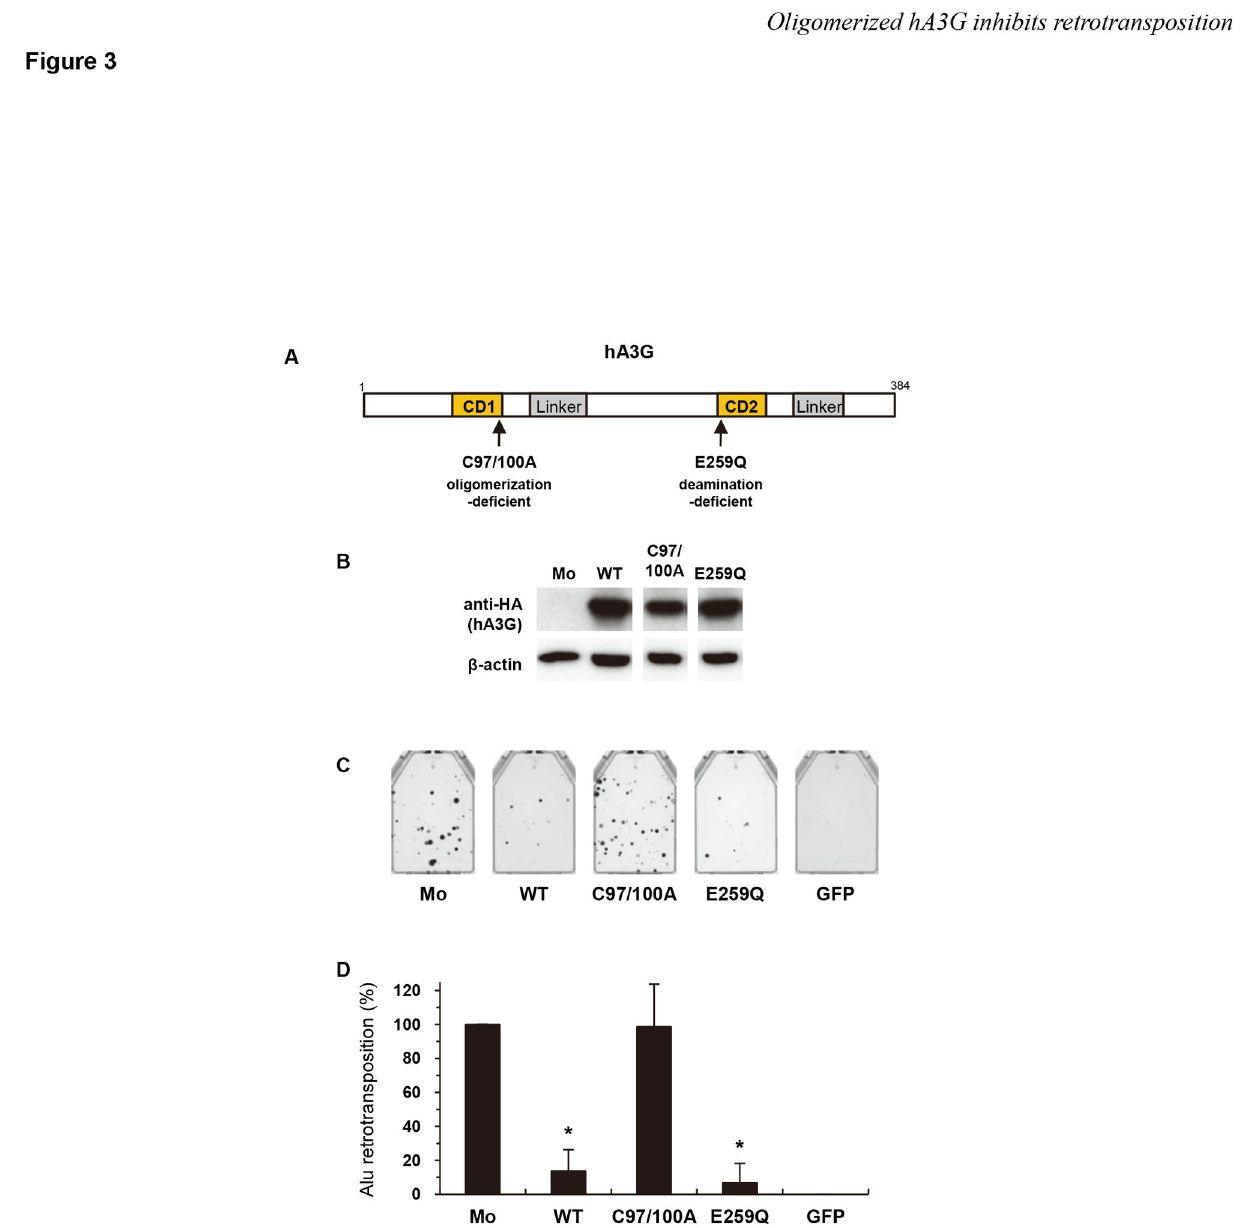
Figure 3. The anti-Alu activity of hA3G is associated with its oligomerization and is independent of its deaminase activity. ( A ) Schematic depiction of two mutants: an oligomerization-deficient mutant, C97/100A, and a deamination-deficient mutant, E259Q. ( B ) Western blot analysis was performed using extracts from 293T cells transfected with plasmids expressing HA- tagged hA3G mutant proteins. Monoclonal antibodies specific for HA (upper) or β-actin (lower) were used. ( C , D ) An Alu retrotransposition assay was performed as described in Figure 1. A GFP expression vector was used as a negative control. Crystal violet-stained G418 R colonies were counted to determine the level of Alu retrotransposition. The data shown are the mean ± SD of triplicate experiments. Mo, mock; WT, wild-type hA3G; GFP, GFP only. * P < 0.005, t -test. doi: 10.1371/journal.pone.0084228.g003 (Y124, Y125, F126, and W127) that have been predicted to be hA3G [34,59]. The structural model of hA3G-4G(124–127) hot spots of protein–protein interaction [68] and have been indicates that the mutant does not form the aromatic cluster, reported to be critical for the RNA-mediated oligomerization of leaving a prominent space between two monomers (compare